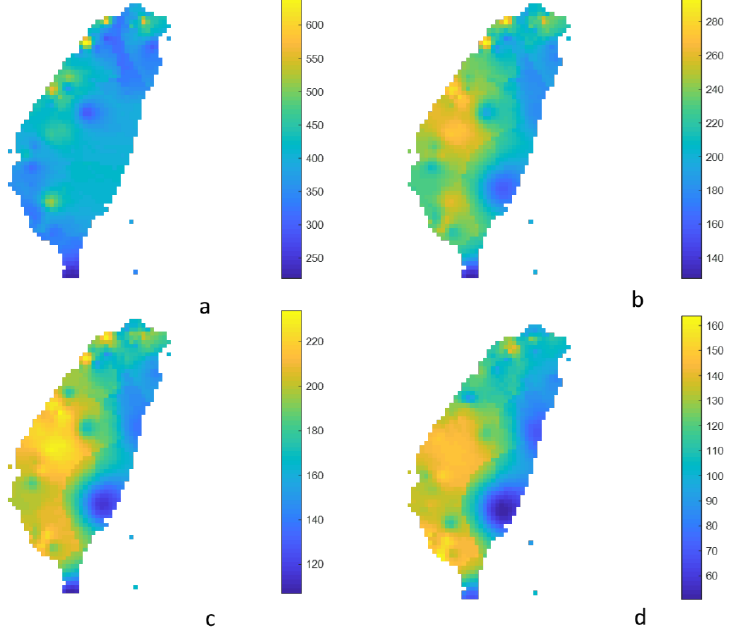
Figure 5. Estimated 1 h- ( a ), 8 h- ( b ), 24 h- ( c ), and 96 h- ( d ) average extreme PM 2.5 concentration for the 5-year return period (unit: µ g / m 3 ).